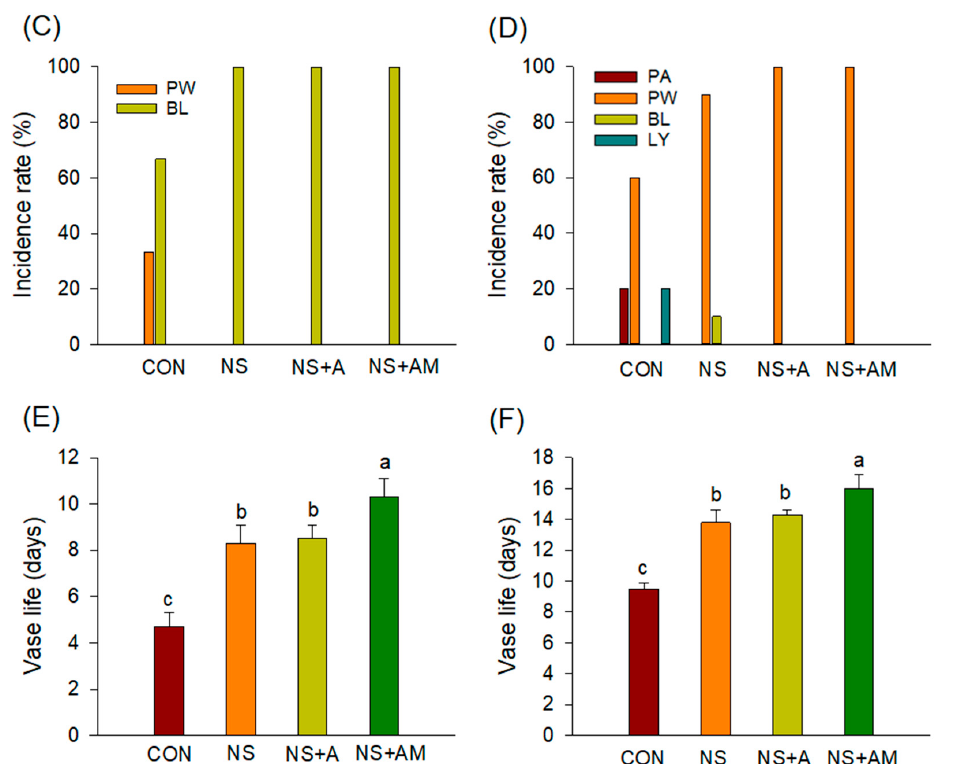
Figure 1. Ornamental quality performance, incidence rate of senescence symptoms, and vase life of ‘Matador’ ( A , C , E ) and ‘Dolcetto’ ( B , D , F ) cut roses. CON, control flowers were held in DW; NS, cut roses were treated with nano silver; NS+A, cut roses were treated with NS and AIB; NS+AM, cut roses were treated with NS, AIB, and 1-MCP. All cut roses were exposed to ethylene (2 µL L − 1 ) for 24 h at 25 ± 1 °C under dark conditions. PA, petal abscission; PW, petal wilting; BL, bluing; and LY, leaf yellowing. Different letters above bars show statistically significant differences among treatments at p < 0.05 based on DMRT. Vertical bars indicate SE of the means ( n = 6).